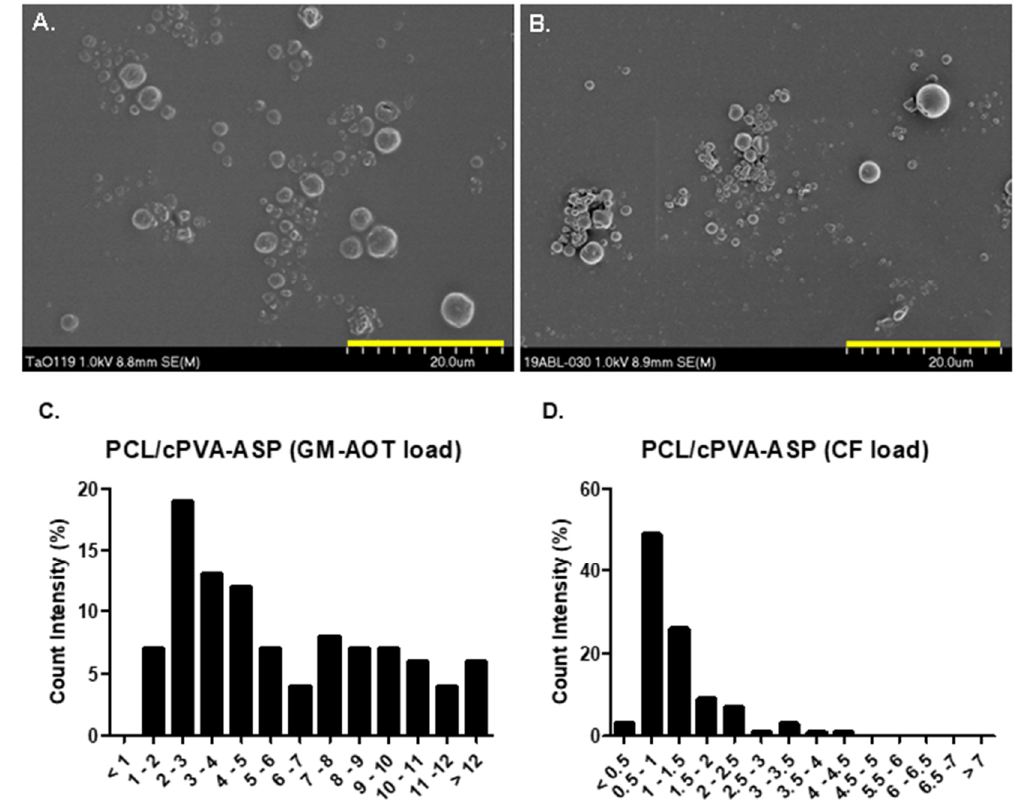
Figure 4. ( A ) PCL/cPVA-ASP microspheres with a GM-AOT drug load. ( B ) PCL/cPVA-ASP microspheres with a CF drug load. ( C ) Histogram showing the size distribution of PCL/cPVA-ASP microspheres with GM-AOT drug load. ( D ) Histogram showing the size distribution of PCL/cPVA- ASP microspheres with CF drug load. Yellow scalebar equals 20 µm.